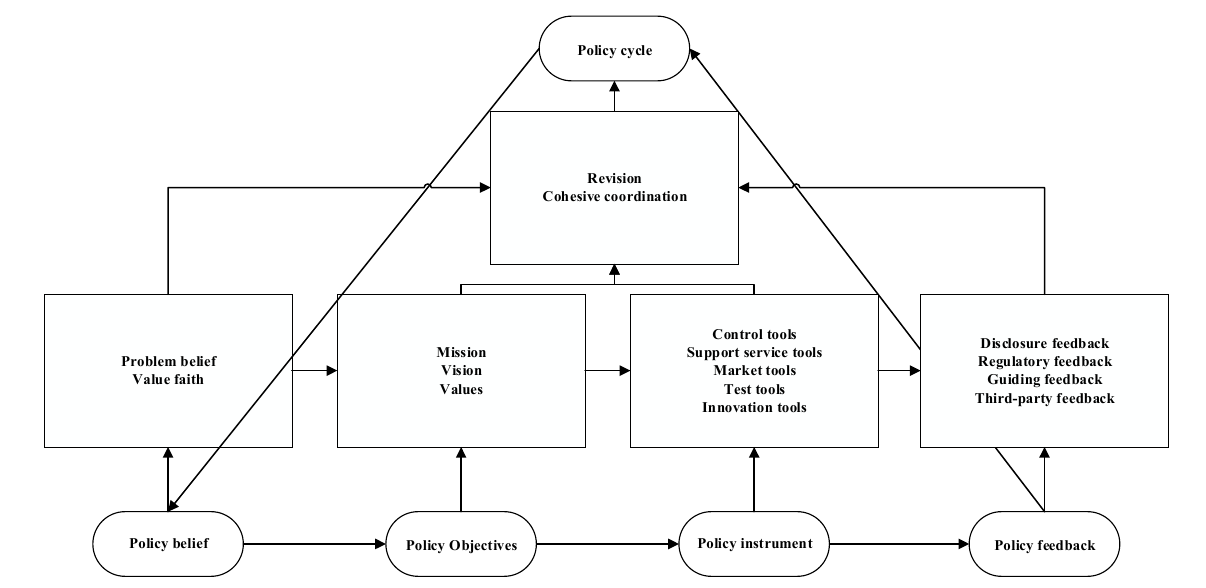
Figure 18. China’s green finance policy governance model.